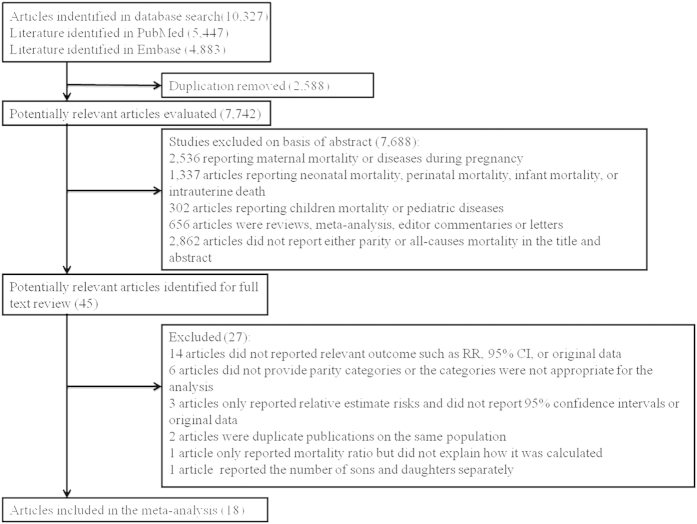
Selection of studies for inclusion in a meta-analysis of parity and all-cause mortality.